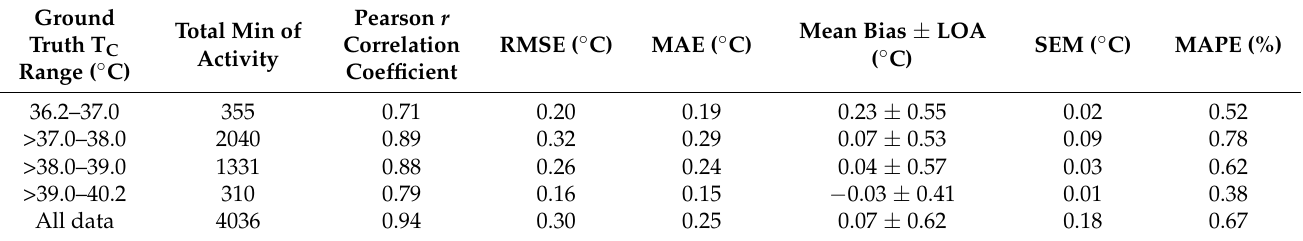
Table 1. Kenzen T C algorithm accuracy metrics binned by 1 ◦ C increases in ground truth T C